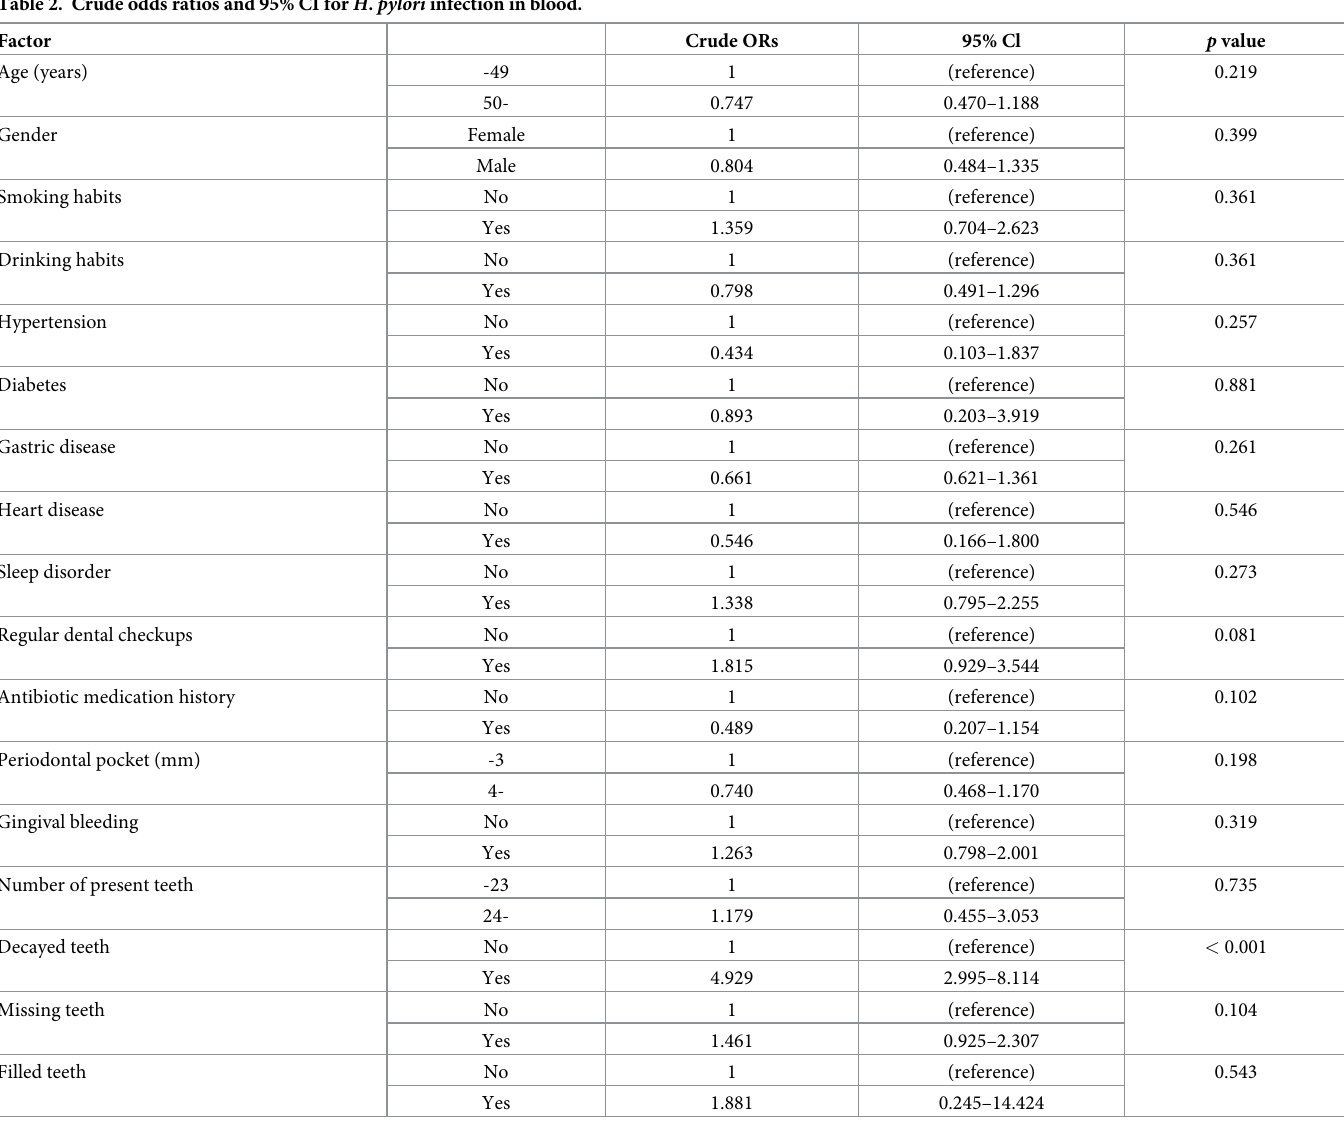
Table 2. Crude odds ratios and 95% CI for H . pylori infection in